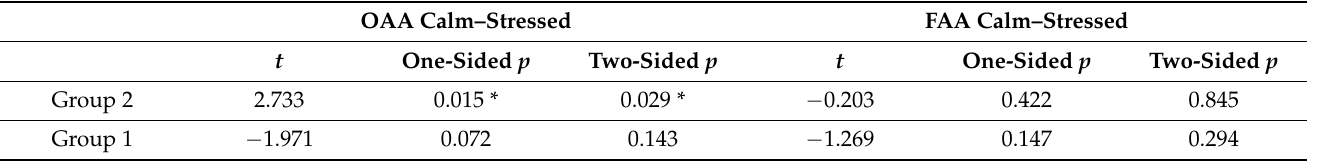
significance, with p value < 0.05.